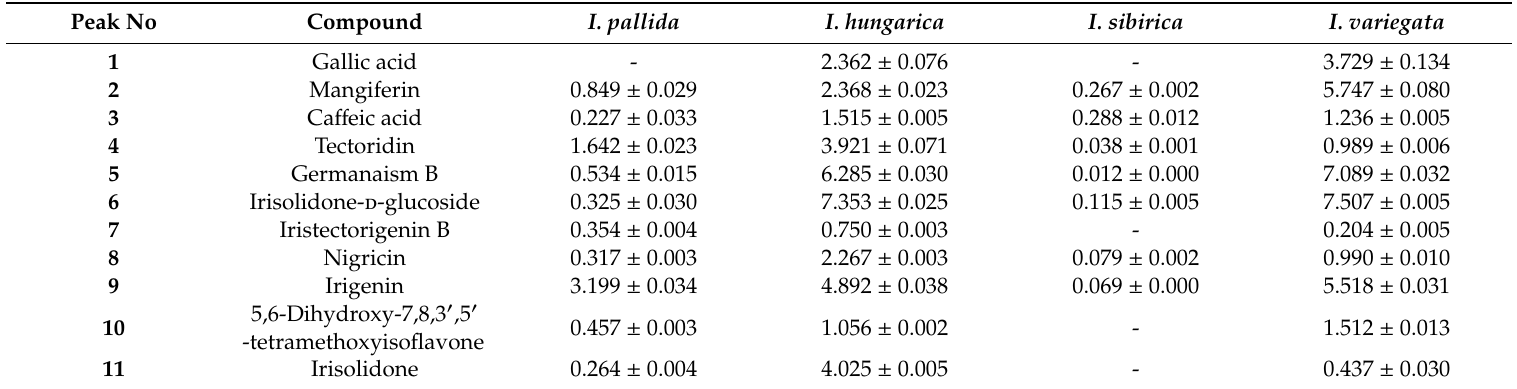
Table 4. Phenolic compounds content of I. pallida , I. hungarica , I. sibirica , and I. variegata rhizomes (mg /